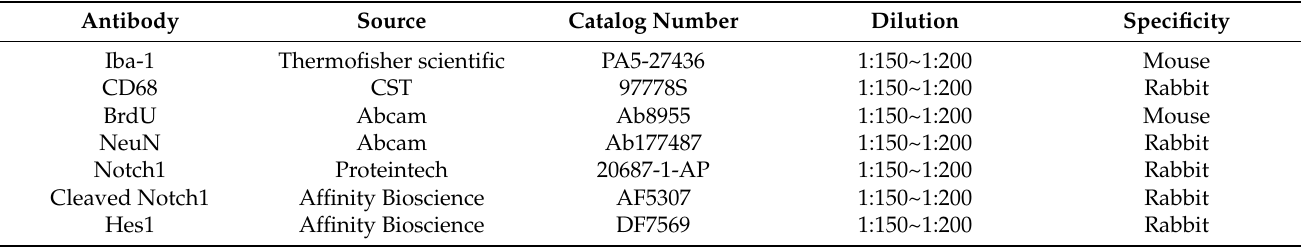
Table 1. Primary antibodies utilized for